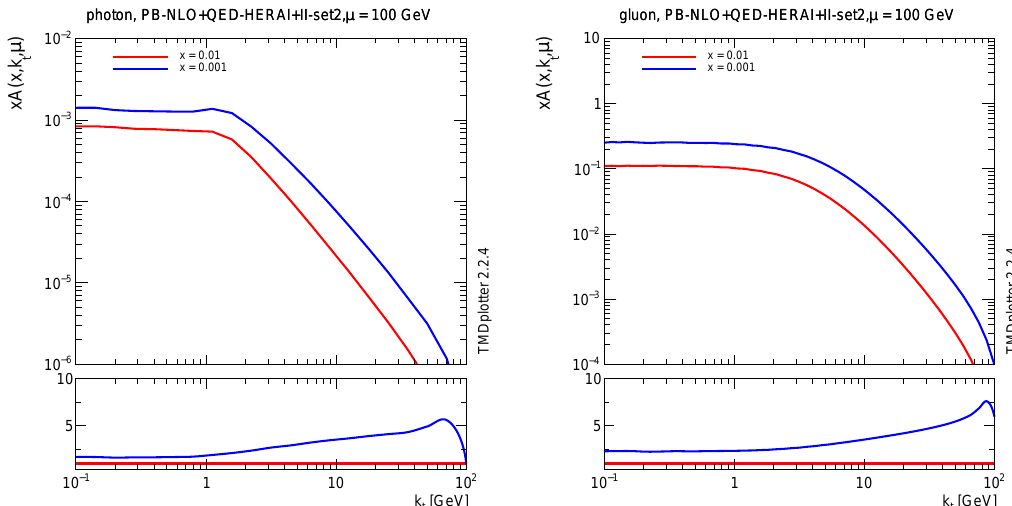
Figure 2: Left: Photon TMD plotted against k µ = 100 GeV and two different x -values. Right: Gluon TMD plotted against k for the same final evolution scale. Note that the range of the y-axis is different in both plots.